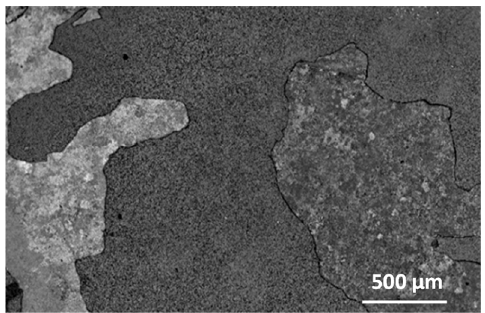
Figure 11. SEM micrograph of Ti-46Al-7Nb-0.7Cr-0.1Si-0.2Ni alloy exposed to air at 900 °C—surface prepared by grinding (fragmentary chipping of products) [30].